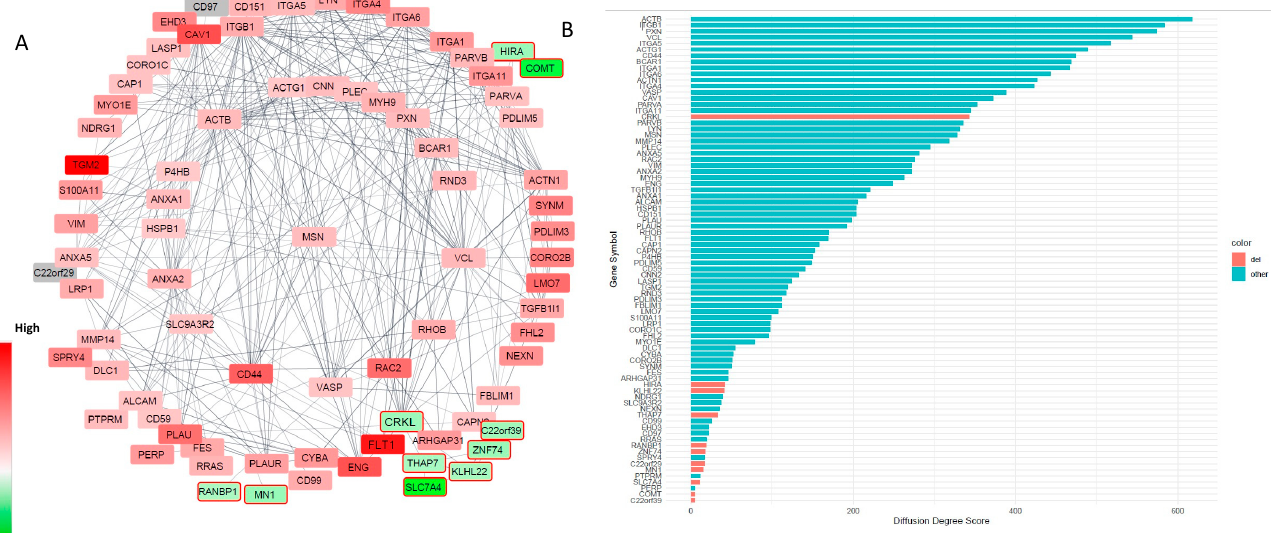
Figure 5. Alterations in the cell junction and adhesion network. ( A ) An altered PPI network involved in cell junction and adhesion functions. Red-dotted rectangle indicates the interaction between CRKL and VEGR1/FLT1. ( B ) The centrality measure analysis of the contribution of each node to the PPI network. The x-axis is the “diffusion degree score” (see the method) and the y-axis is the nodes (gene symbols) ranked according to their diffusion degree score.